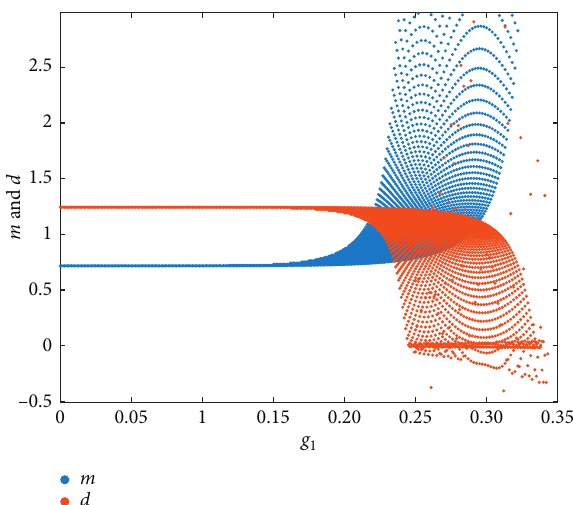
Figure 5: The effect of the adjustment coefficient on the leadership self-leadership coefficient and relational leadership coefficient.